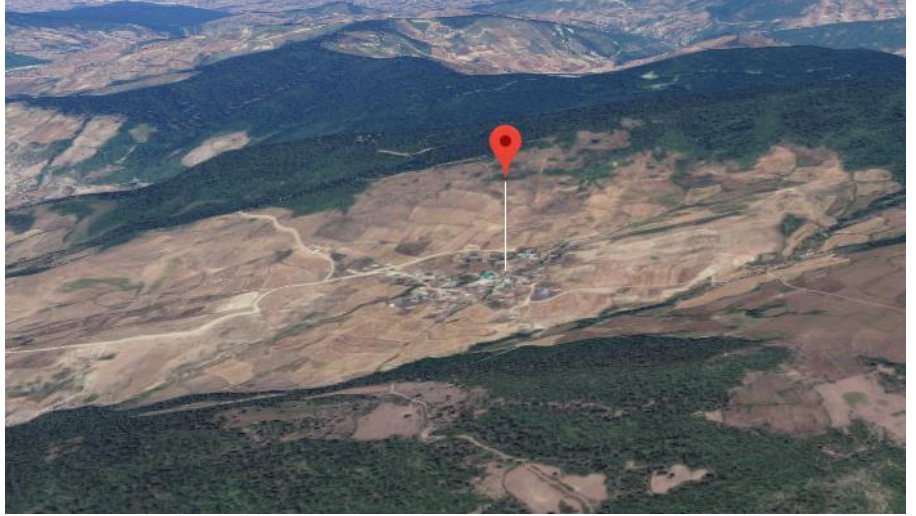
Fig. 2. Sertillite map of Barma Zarem Village (N 53°43'57.6